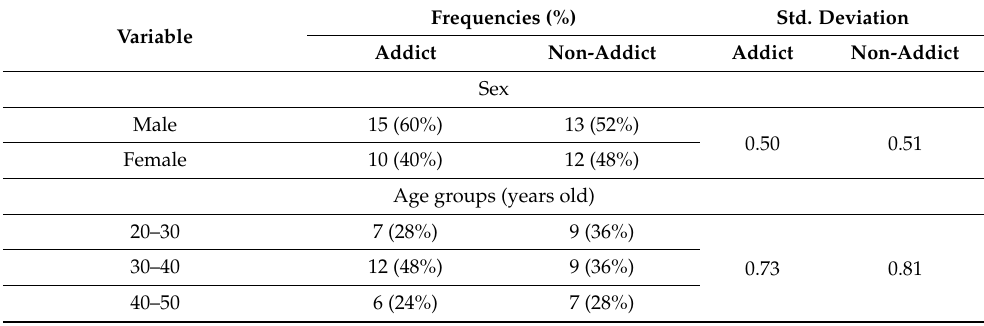
Table 1. The distribution of parameters